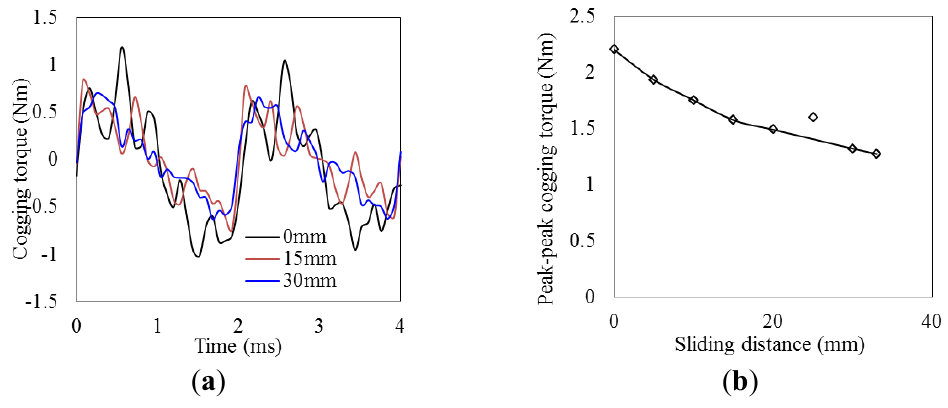
Figure 14. Average electromagnetic torque with the PMs sliding distance.